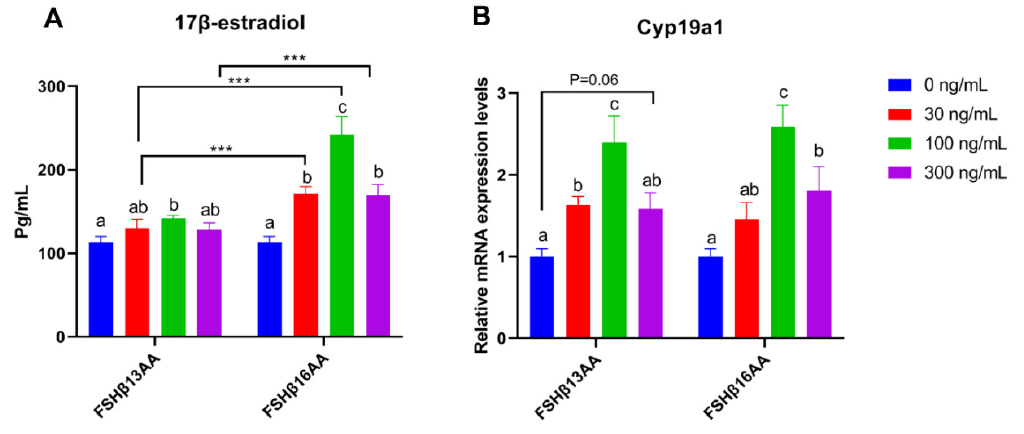
Figure 6. FSH β 13AA/FSH β 16AA promotes the estradiol production in vitro. Effects of the different dosages of FSH β 13AA/FSH β 16AA addition on the 17 β -estradiol production ( A ) and the mRNA expressions of Cyp19a1 ( B ) in the cultured primary ovarian granular cells isolated from the mice on day 25. Data are expressed as mean ± SEM. Cyp19a1 , cytochrome P450, family 19, subfamily A, member 1 (aromatase). *** p < 0.001. a–c Within a treatment group, the means without a common letter